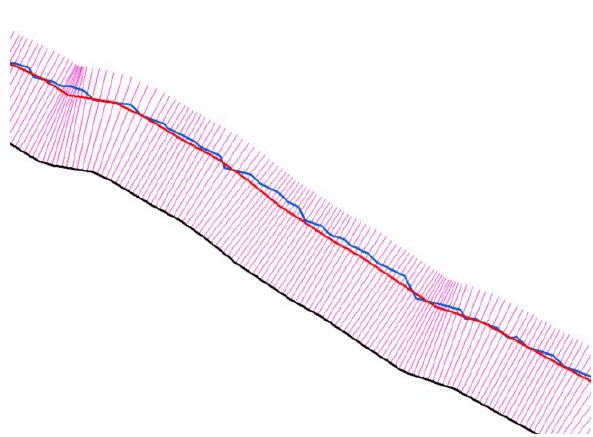
Figure 6. Transects for GOKTURK-2 image.